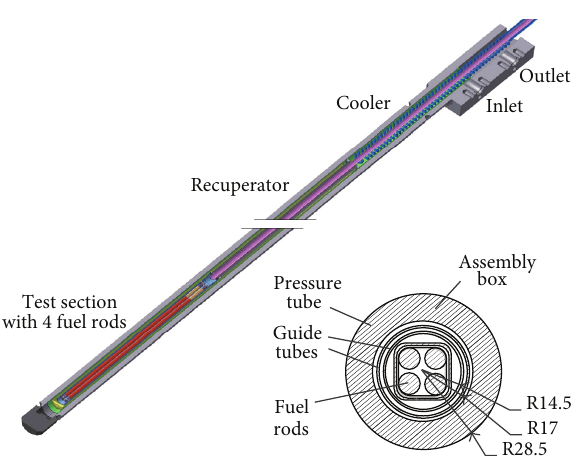
Figure 1: Concept of the active channel for SCWR fuel qualification.